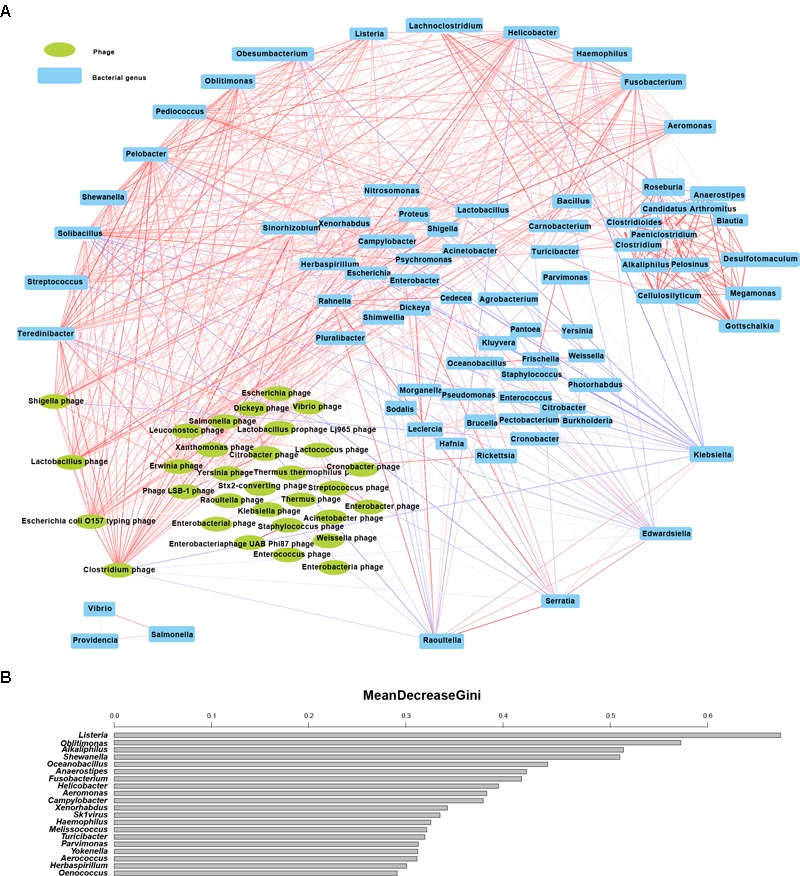
Discovery of important structural genera of gut microbiota with age. (A) Significant correlations (t-test, p < 0.05) in 112 genera of 52 stable microbial families (families with a presence rate above 70% in all samples) during cub development. The red and blue lines denote positive and negative correlations of the related genera, respectively; the thicker the line, the stronger are the correlations between paired genera. The uppermost genera have more than 30 links with other genera; genera at the bottom are those with numerous negative correlations with other genera; genera at the bottom left are bacteriophage groups; the rightmost area shows relatively independent groups with strong positive correlations. (B) The top 20 most important genera by random forest (RF) analysis (by age). The bar length shows the ability of microbes to decrease node impurity in the RF model. A large value means that the genus is very important for determining microbiota structure.